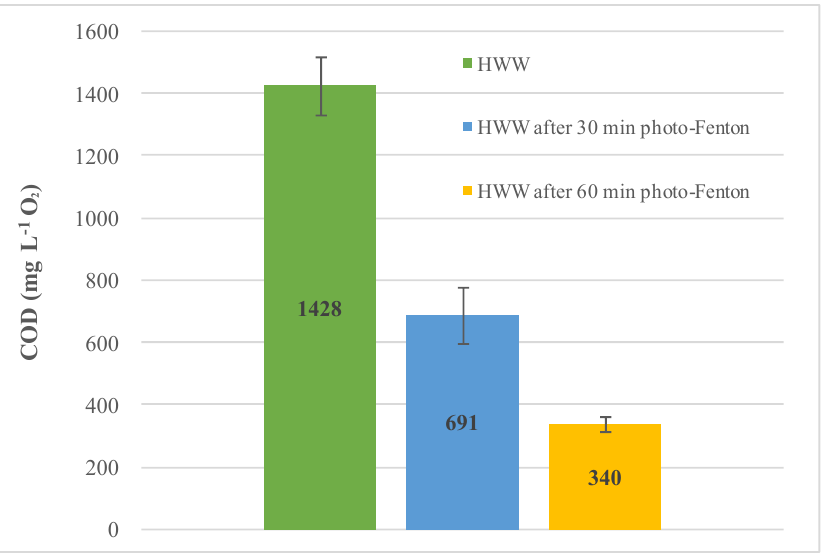
Figure 1. Results for COD analysis of spiked HWW during photo-Fenton treatment, using the miniaturized PhotoMetrix PRO method, at t=0, t=30, and t=60 min.